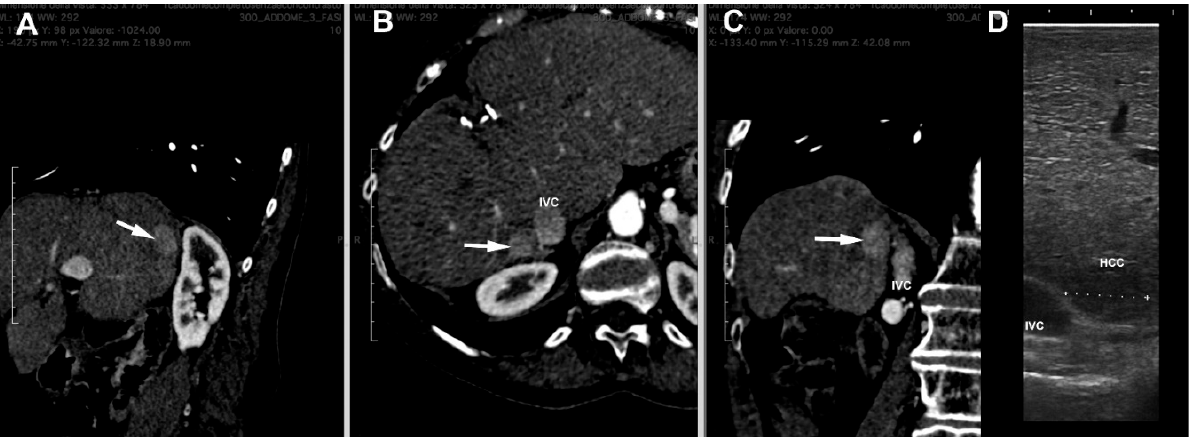
Figure 2. Multiplanar reconstruction of CT scan ( A = sagi tt al, B = axial and C = coronal planes) of a HCC nodule (arrow) in the seventh segment contiguous to inferior vena cava (IVC). D = laparo- scopic ultrasound image of the nodule.